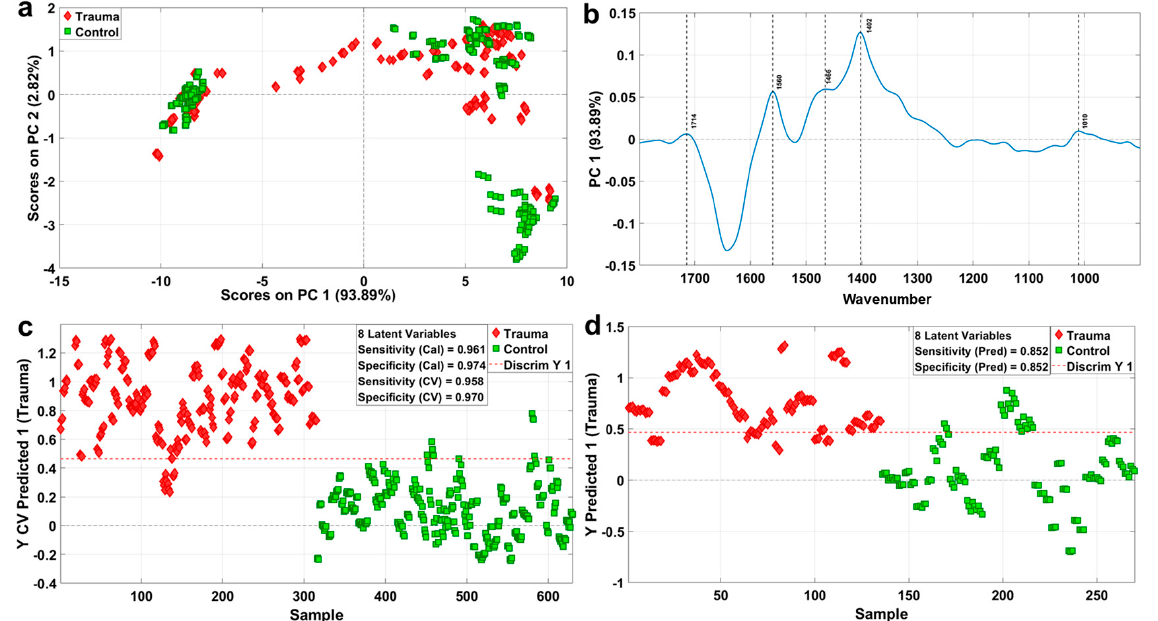
Figure 3. Classification model of rat muscle trauma and its accuracy index. ( a ) PCA scores in the direction of PC1 and PC2 of the trauma group and the control group. The red markers are trauma group, and the green markers are control group. ( b ) Loading plot on PC1 from PCA analysis, marked with significant peaks. ( c ) Trauma classification model and sensitivity and specificity in-dexes established based on training sets of trauma group and control group. The red markers are trauma group, and the green markers are control group. ( d ) Trauma classification prediction model and related evaluation model indexes established based on the test sets of trauma group and control group. The red markers are trauma group, and the green markers are control group.